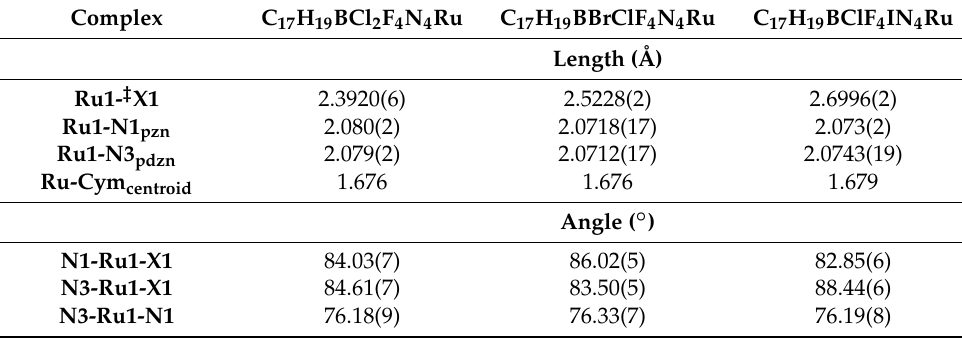
Table 2. Selected bond length/Å and angles ( ◦ ) from the crystal data for Ru1-3